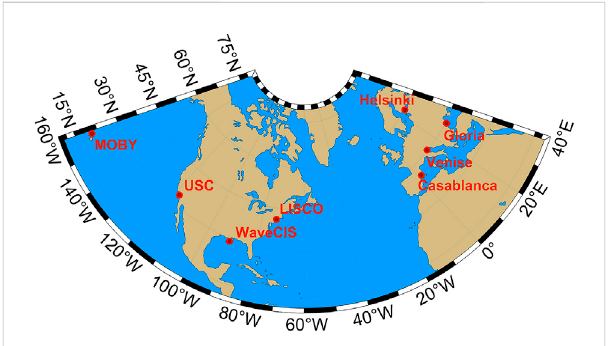
FIGURE 1 Areas of study: Global map showing MOBY area and all AERONET-OC stations used in this